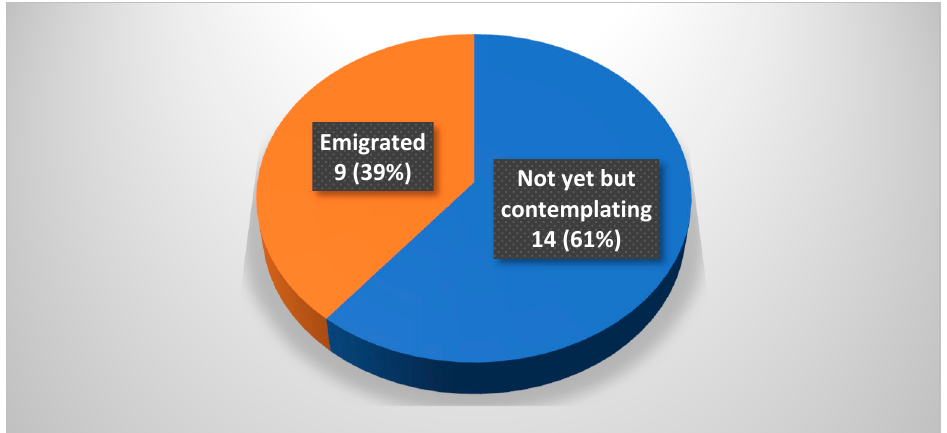
Figure 2. Emigration status of the study participants (n = 23).